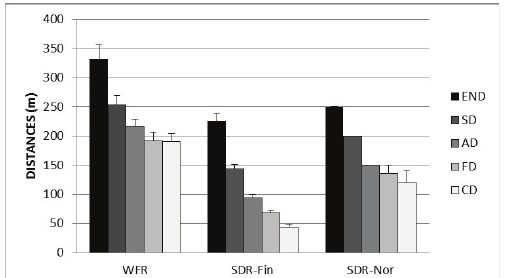
Fig. 3. Response distances (mean ± SD) of wild for- est reindeer (WFR) and of semi-domestic reindeer in Finland (SDR-Fin) and in Norway (SDR-Nor) in groups disturbed by a directly approaching hu- man on foot/snowshoes in 2010-12. Sample sizes are: END (encounter), SD (sight), AD (alert), and FD (flight distance), n = 20 for WFR, n = 32 for SDR-Fin and n = 3 for SDR-Nor, and CD (closest distance), n = 15 for WFR, n = 26 for SDR-Fin and n = 2 for